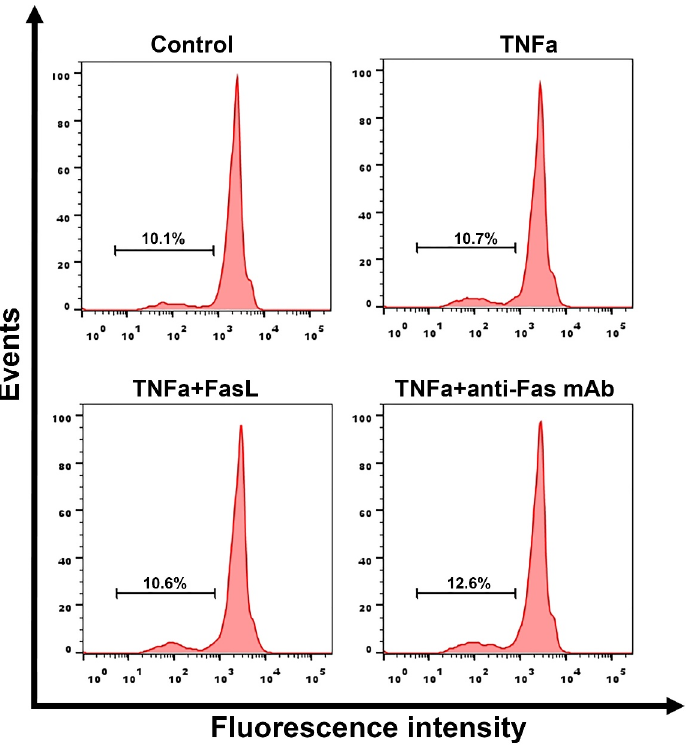
Figure 5. Cell death of L ‐ MSCs pretreated with TNF ‐α . L ‐ MSCs were incubated with 20 ng/mL TNF ‐ α for 48 h and then incubated with anti ‐ Fas mAb (2 μ g/mL) or FasL (500 ng/mL) for 24 h. The bars indicate the percentage of cells with fragmented DNA. Representative data obtained for a single culture of L ‐ MSCs are shown.